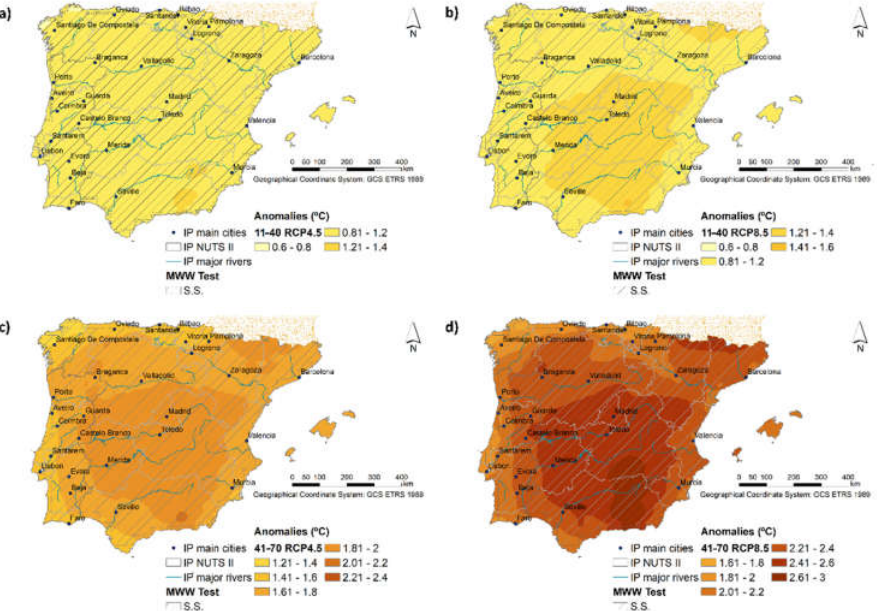
Figure 3. Annual mean temperature ( °C ) anomalies (Mann–Whitney–Wilcoxon test at a 5% signif- icance level) for the period ( a , b ) 2011  2040, ( c , d ) 2041–2070, with respect to the baseline climate (1961–1990), under RCP4.5 ( left ) and RCP8.5 ( right